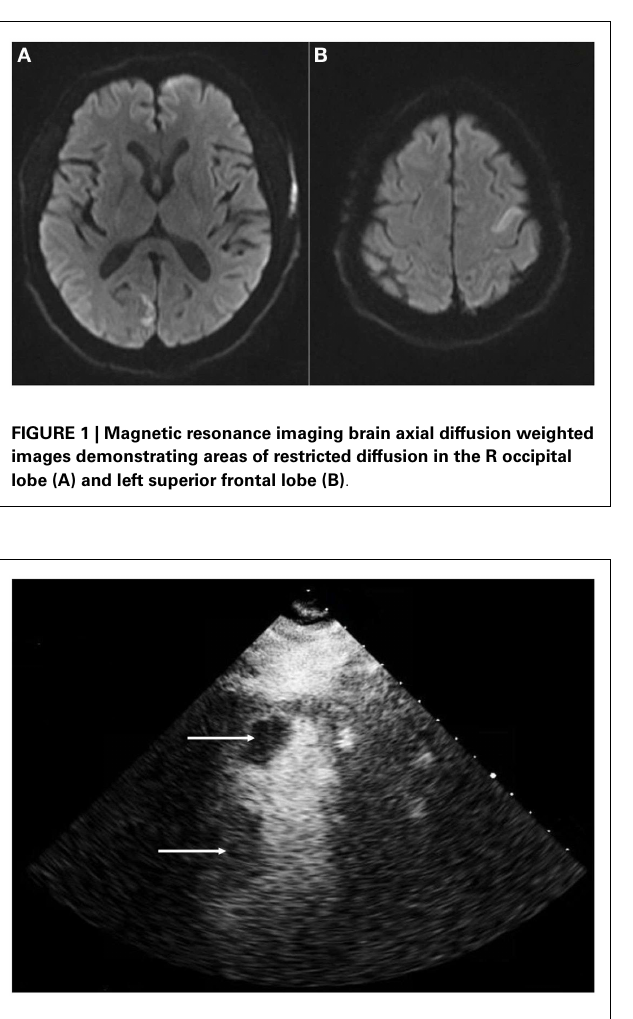
FIGURE 2 |Transthoracic echocardiogram, apical 2 chamber view with contrast demonstrating a left ventricular apical thrombus (2.4cm × 1.4cm) (top arrow) and a second thrombus (1.6cm × 2.2cm) (bottom arrow) adherent to the interventricular septum